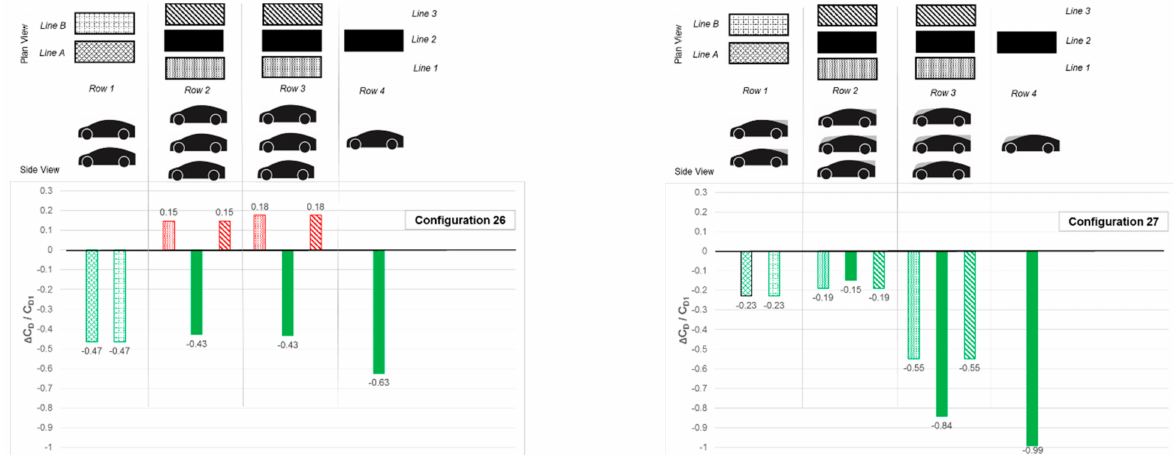
Figure 13. Triple-Line configuration with offset lead models. Configuration 26 comprises models of B1-style. Configuration 27 comprises models of B2/B3/B4